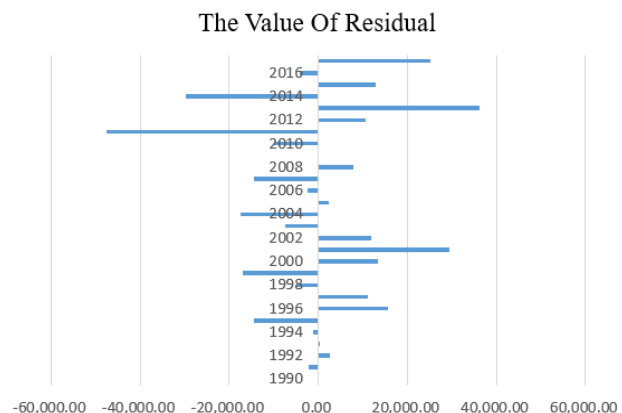
Figure 11. The value of residual.